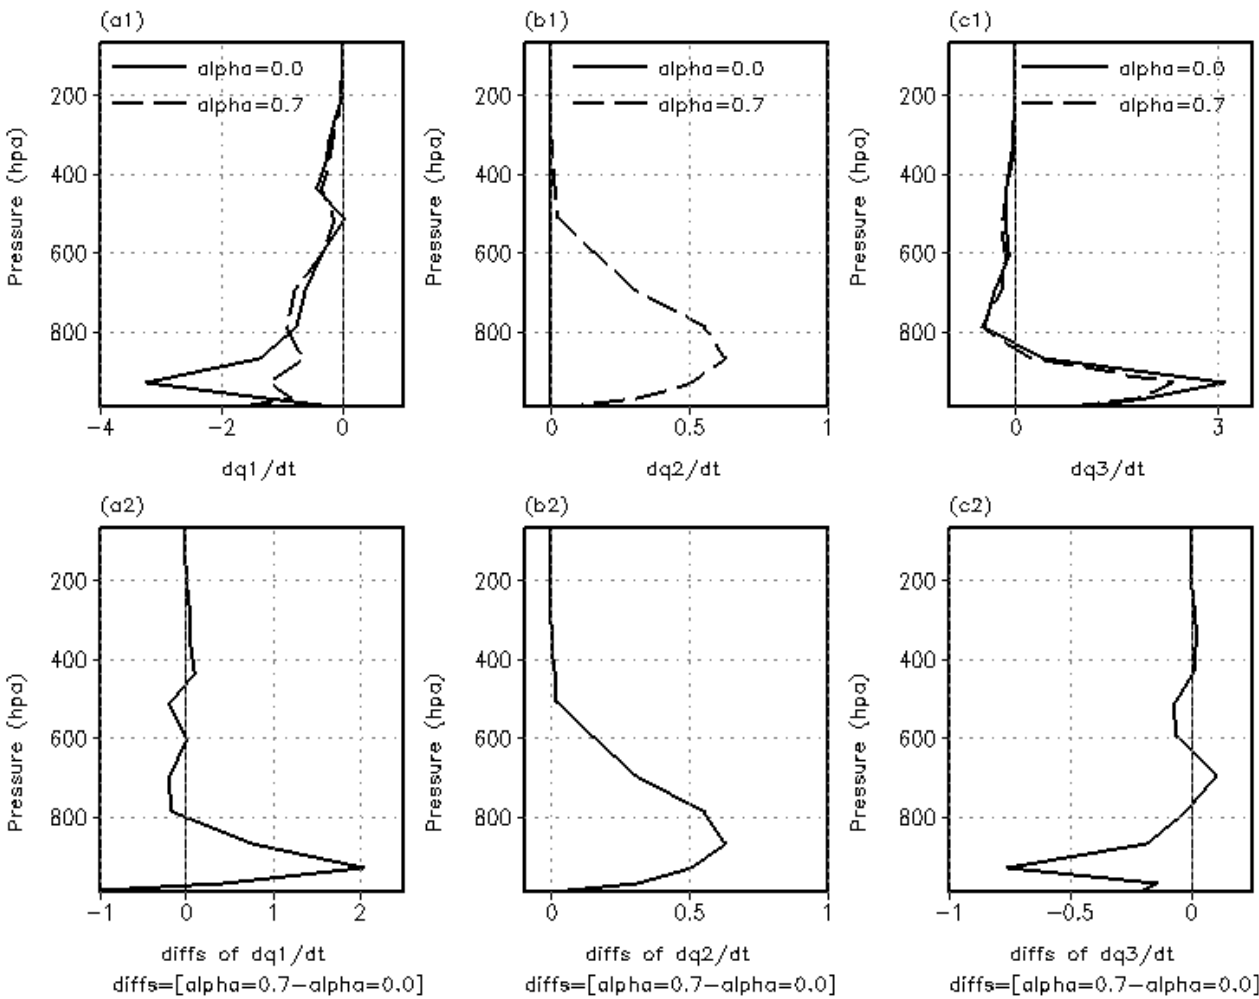
Fig. 10. Vertical profile of the the area averaged (0 to 360 and 7 ◦ S to 7 ◦ N), time mean, quantities, (a1) dq1/dt (specific humidity tendency due to condensation) for α =0.7 and α =0.0. (kg/m 2 /day), (b1) dq2/dt (specific humidity tendency due to evaporation in the downdraft) for α =0.7 and α =0.0 (kg/m 2 /day), (c1) dq3/dt (specific humidity tendency due to lateral moisture advection into the region) for α =0.7 and α =0.0 (kg/m 2 /day), (a2) dq1/dt difference between α =0.7 and α =0.0 (kg/m 2 /day), (b2) dq2/dt difference between α =0.7 and α =0.0 (kg/m 2 /day), (c2) dq3/dt difference between α =0.7 and α =0.0 (kg/m 2